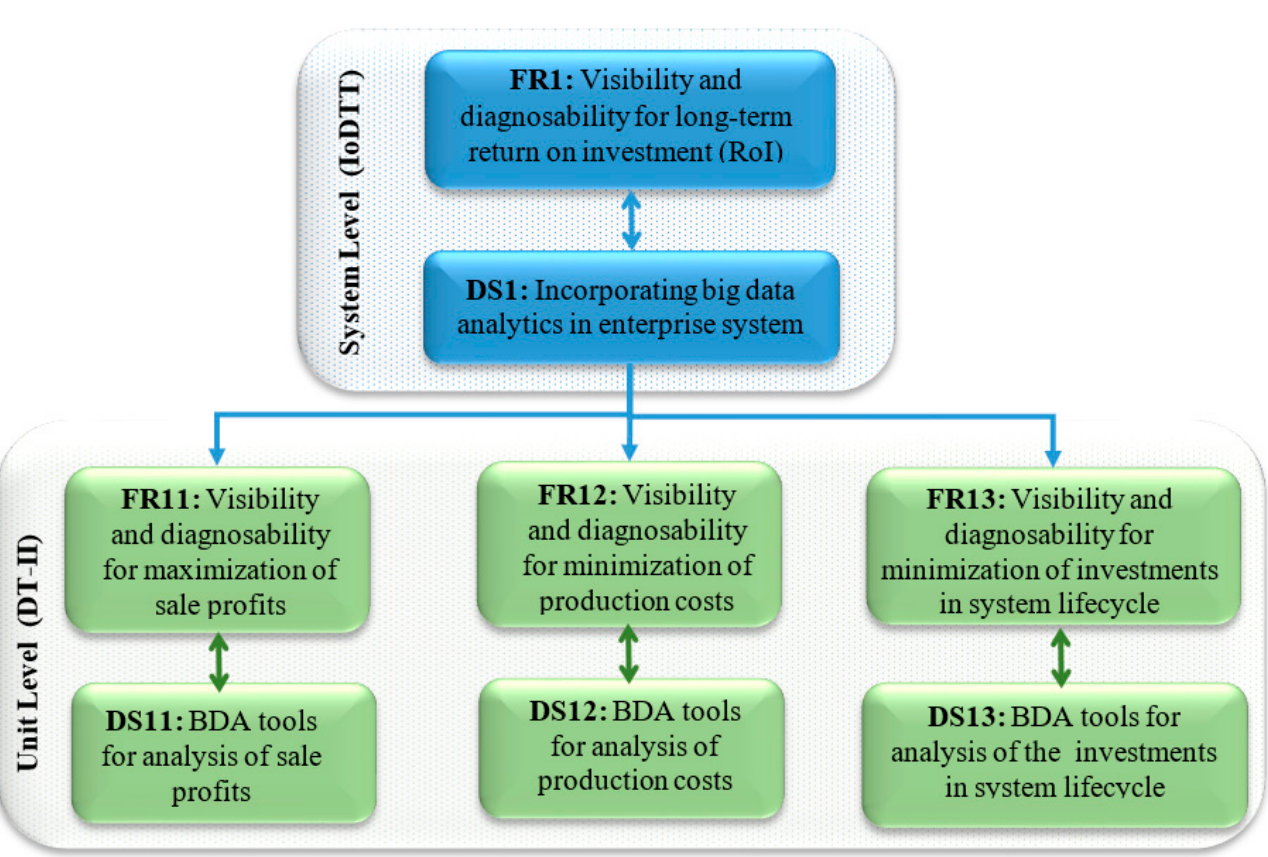
Figure 2. Case study I–Improve visibility and diagnosability by big data analytics (BDA).